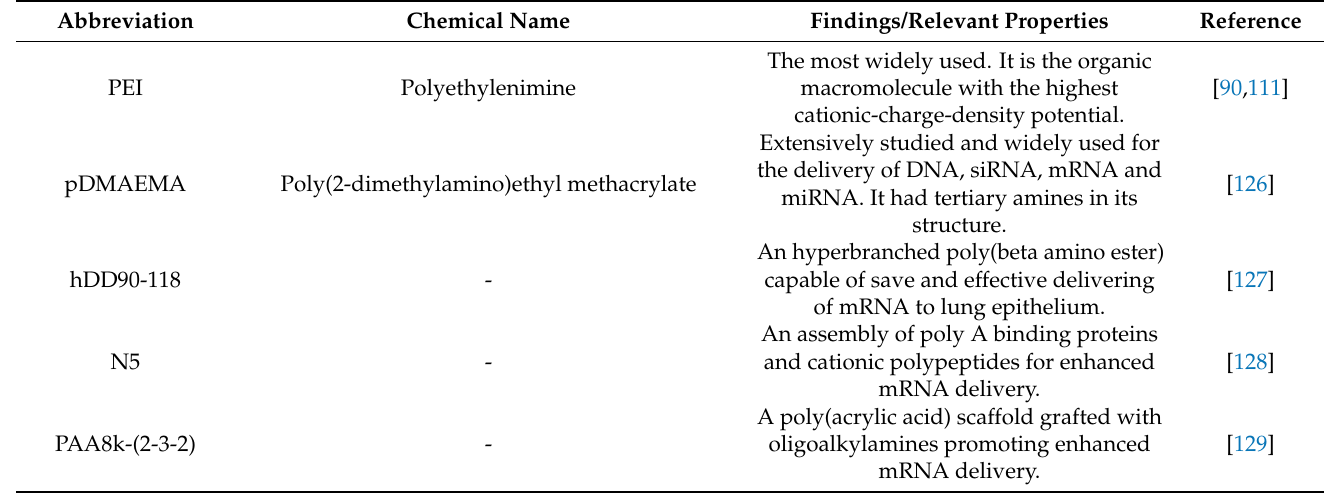
Table 2. Some synthetic polymers frequently used for nucleic acids (NA)